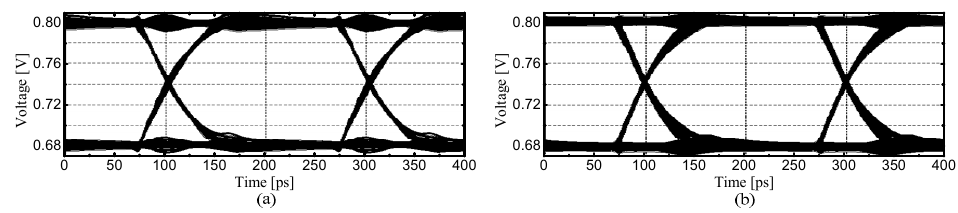
Figure 15. Eye diagrams using the proposed technique with a 5 Gbps, 60,000 bit PRBS. ( a ) Channel 1 (outer line) and ( b ) channel 2 (inner line).